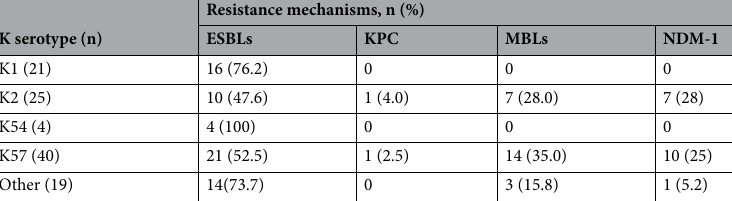
Table 2. The prevalence of resistance mechanisms in K. pneumoniae belonging to different K serotypes. ESBLs—extended spectrum beta-lactamases, KPC—carbapenemase class A, MBLs—metallo-β-lactamases, NDM-1—New Dehli metallo-β-lactamase, OXA-48—carbapenemase class